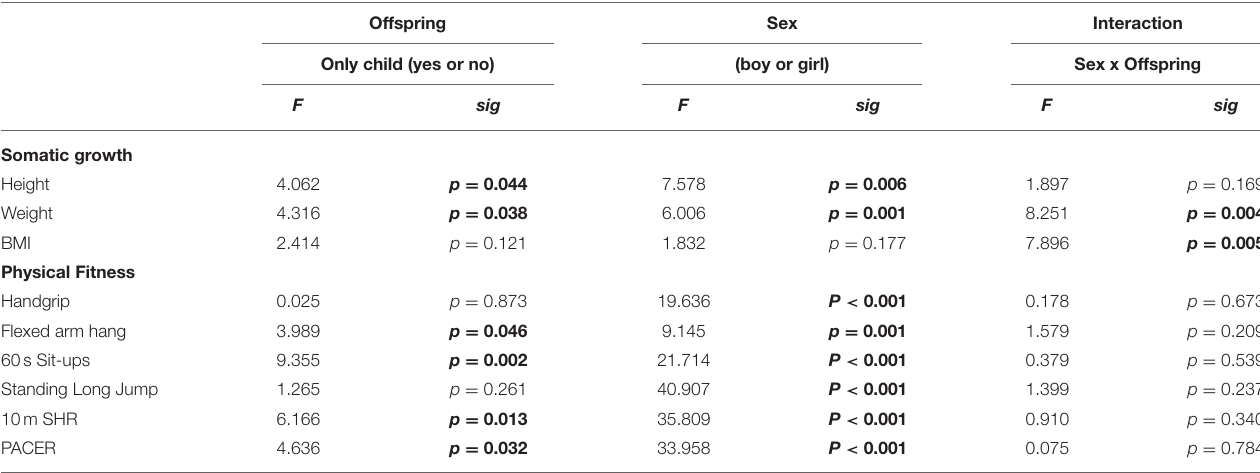
TABLE 2 | Main effects for Offspring condition, Sex, and interaction between them, controlling for decimal age, for each somatic and physical